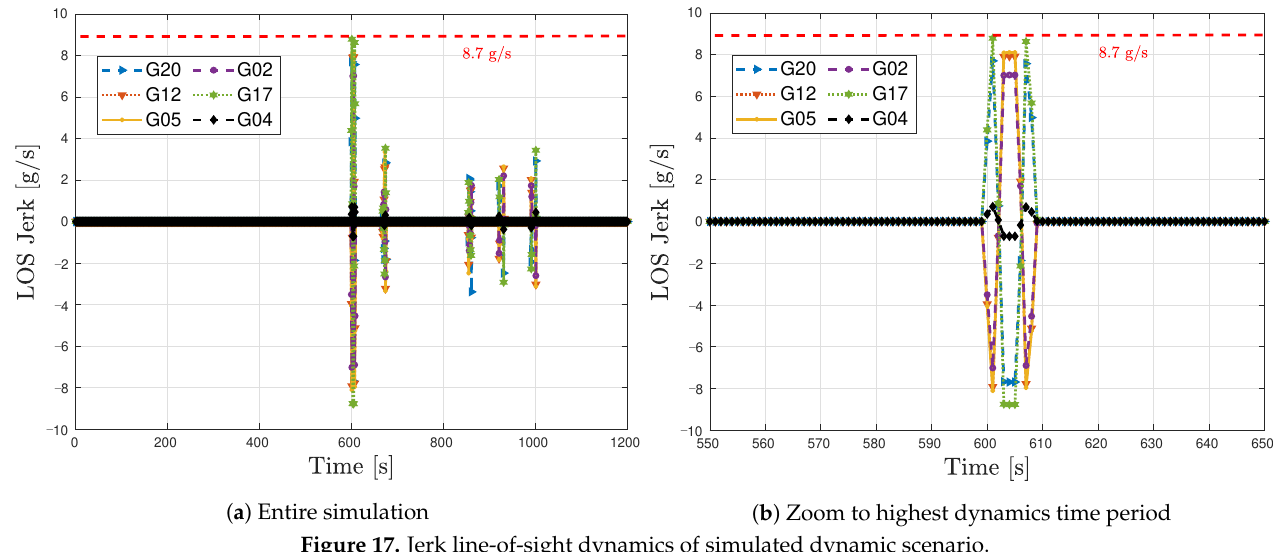
( b ) Zoom to highest dynamics time period Figure 17. Jerk line-of-sight dynamics of simulated dynamic